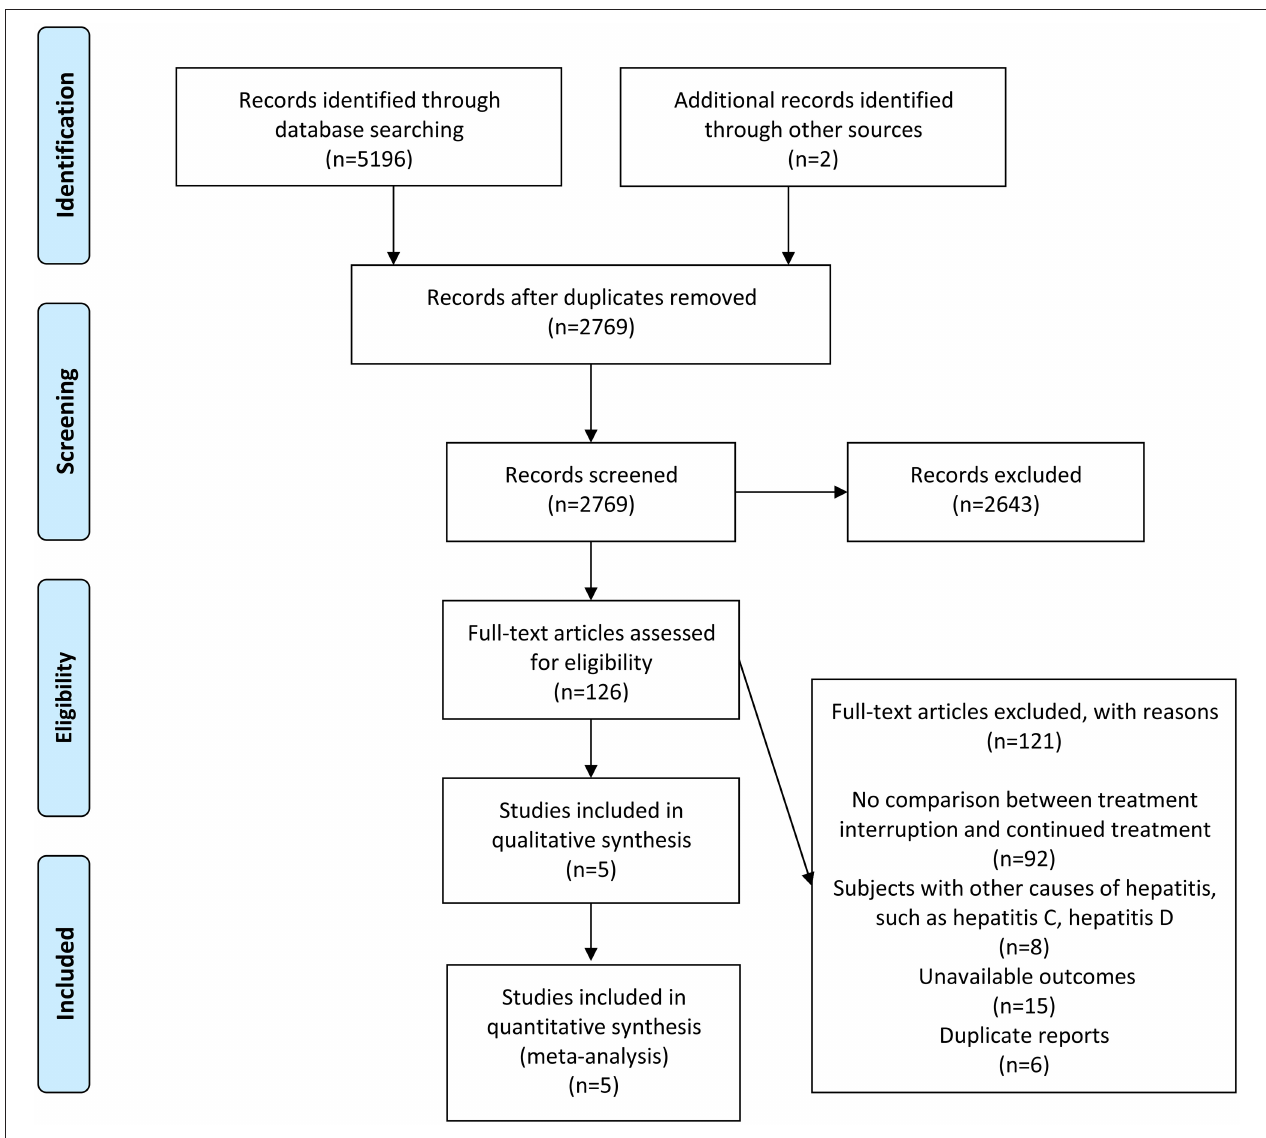
FIGURE 1 | Flow diagram describing inclusion and exclusion